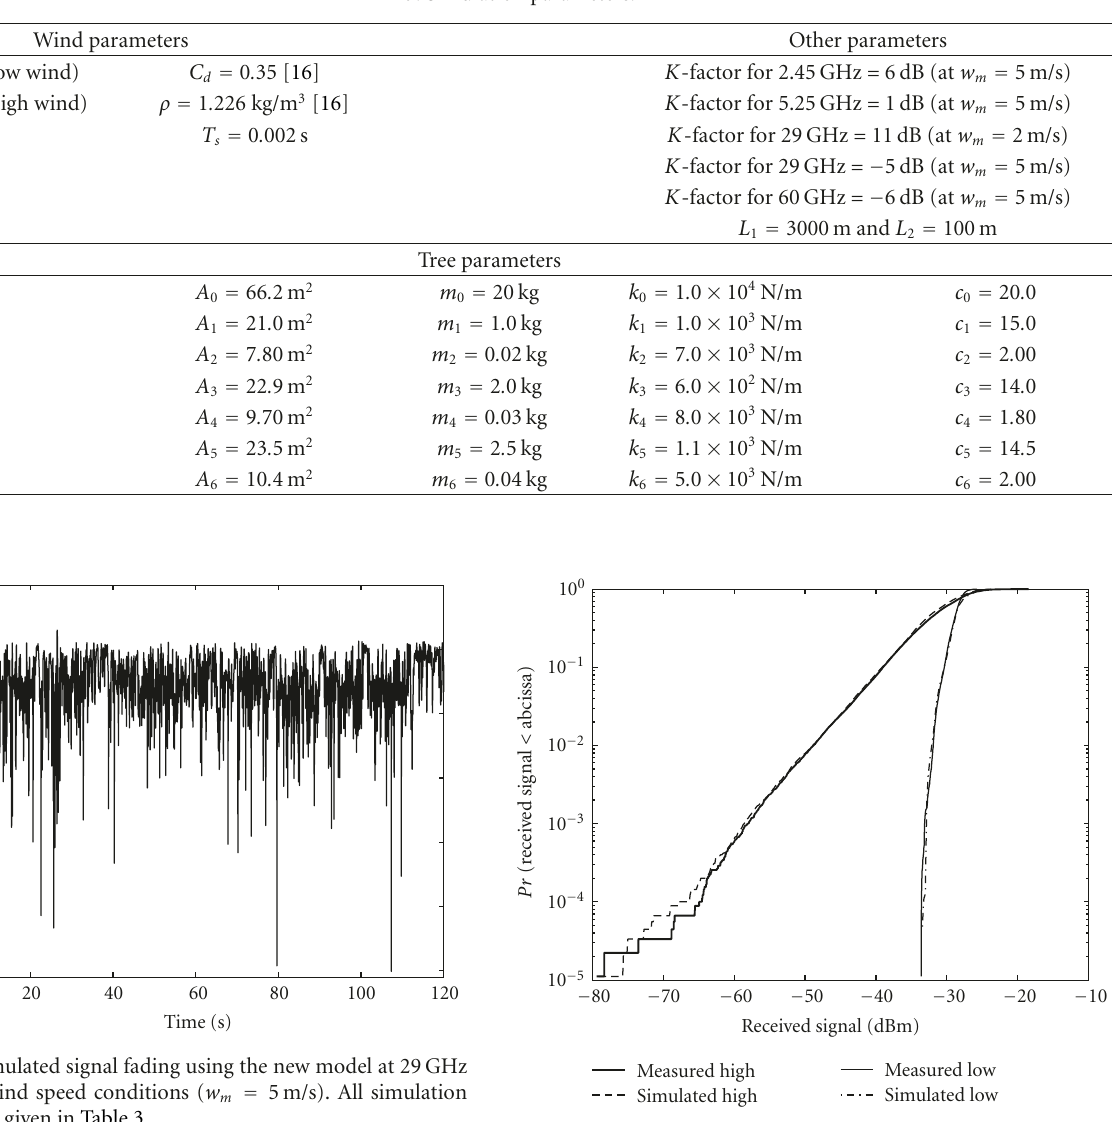
Table 3: Simulation parameters.